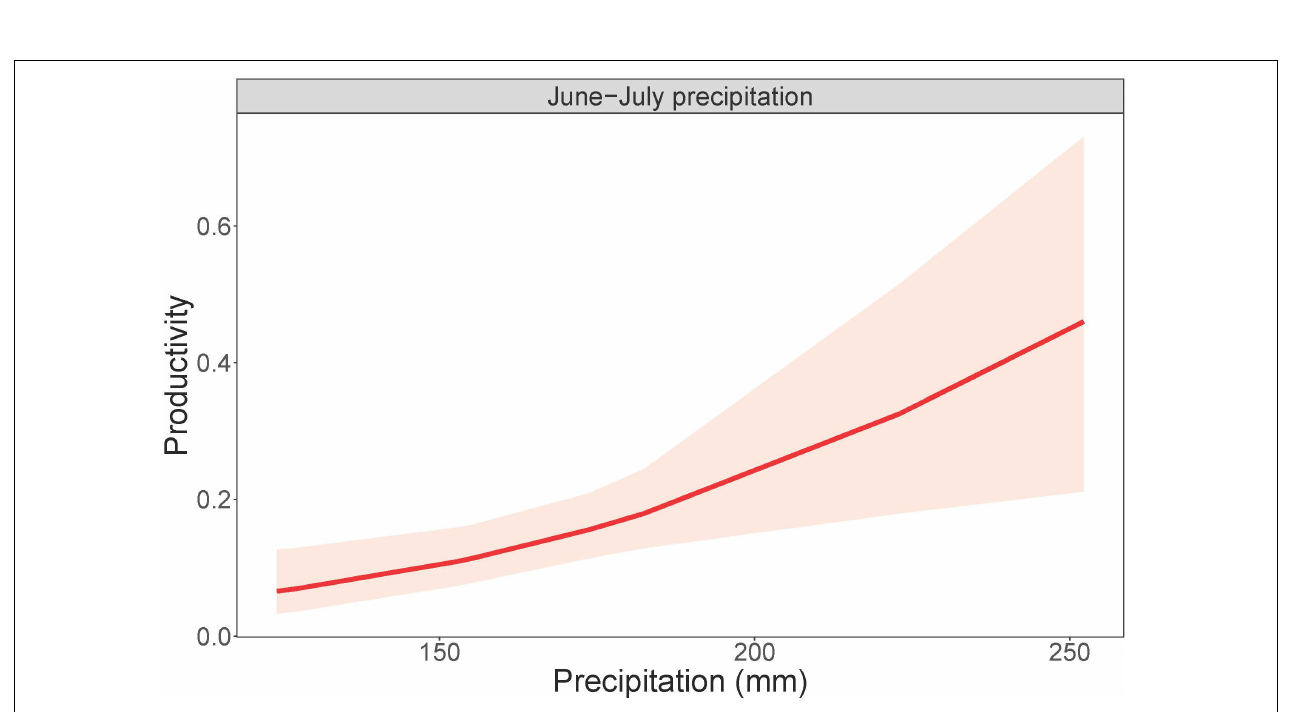
FIGURE 5 | Cowbird productivity in response to summer precipitation. Total June-July precipitation plotted against cowbird productivity, or the probability of encountering a juvenile bird, within a 95% confidence interval.